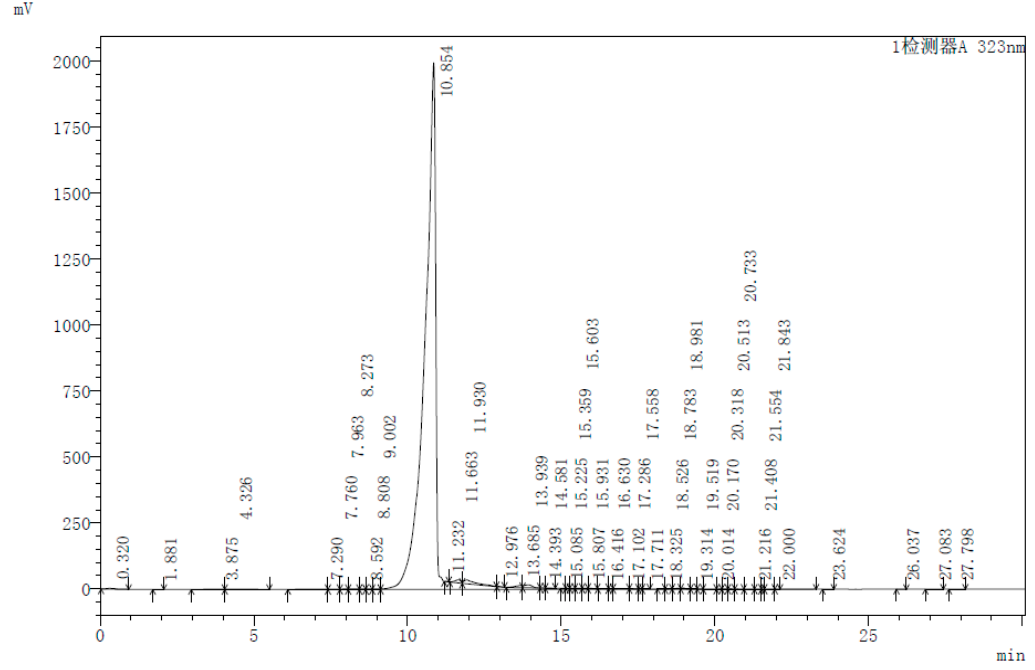
Figure C2. HPLC chromatogram of synthesized Dp44mT.